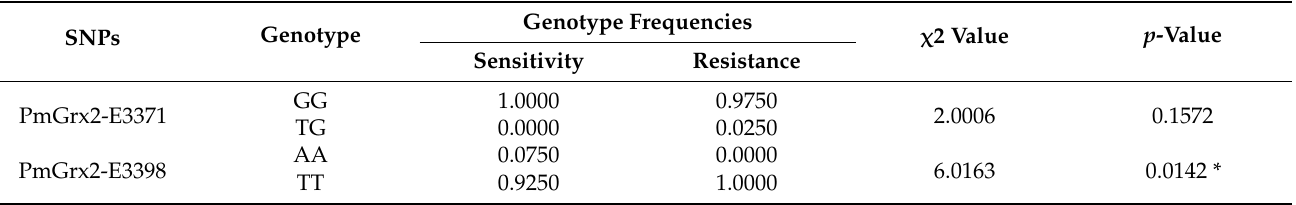
Table 3. Correlation analysis between the SNPs of PmGrx2 and ammonia-N-stress-tolerance